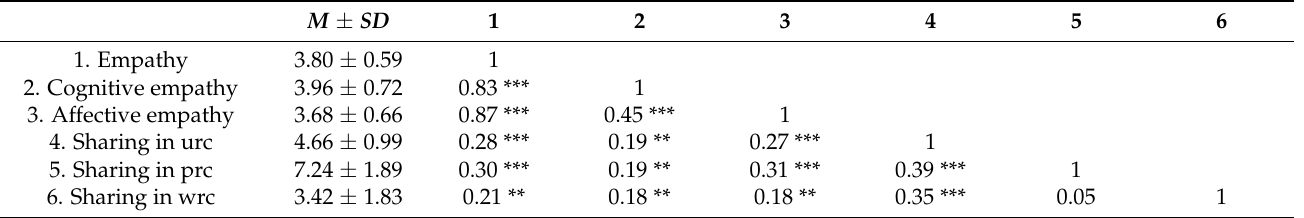
Table 2. Means, SDs, and correlations among empathy, cognitive empathy, affective empathy, and sharing ( N =